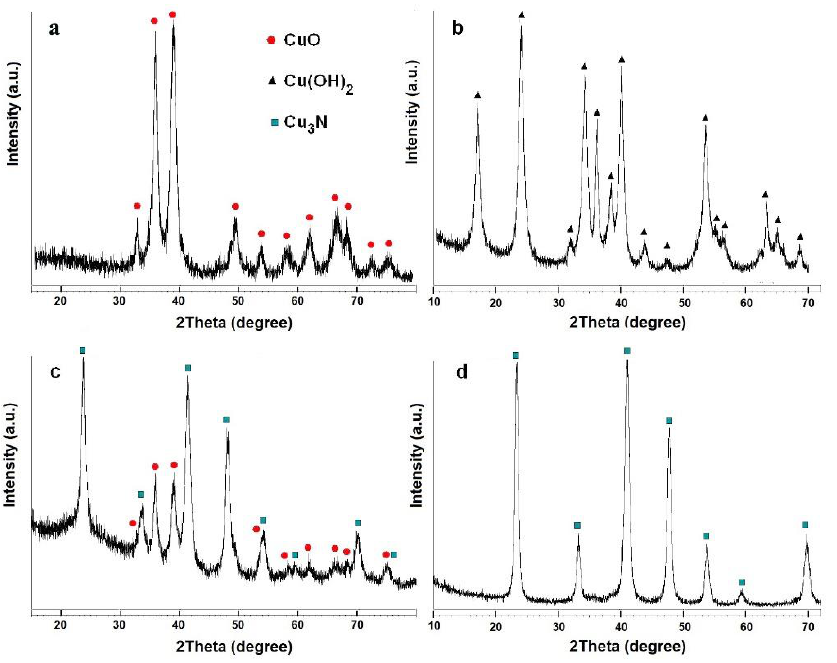
Figure 5. X-ray diffraction patterns of: ( a ) CuO, ( b ) Cu(OH) 2 powders as-made and ( c ) CuO ( 2a ), ( d ) Cu(OH) 2 ( 3b ) following ammonolysis. Red circles indicate CuO, black triangles indicate Cu(OH) 2 and black squares represent Cu 3 N.